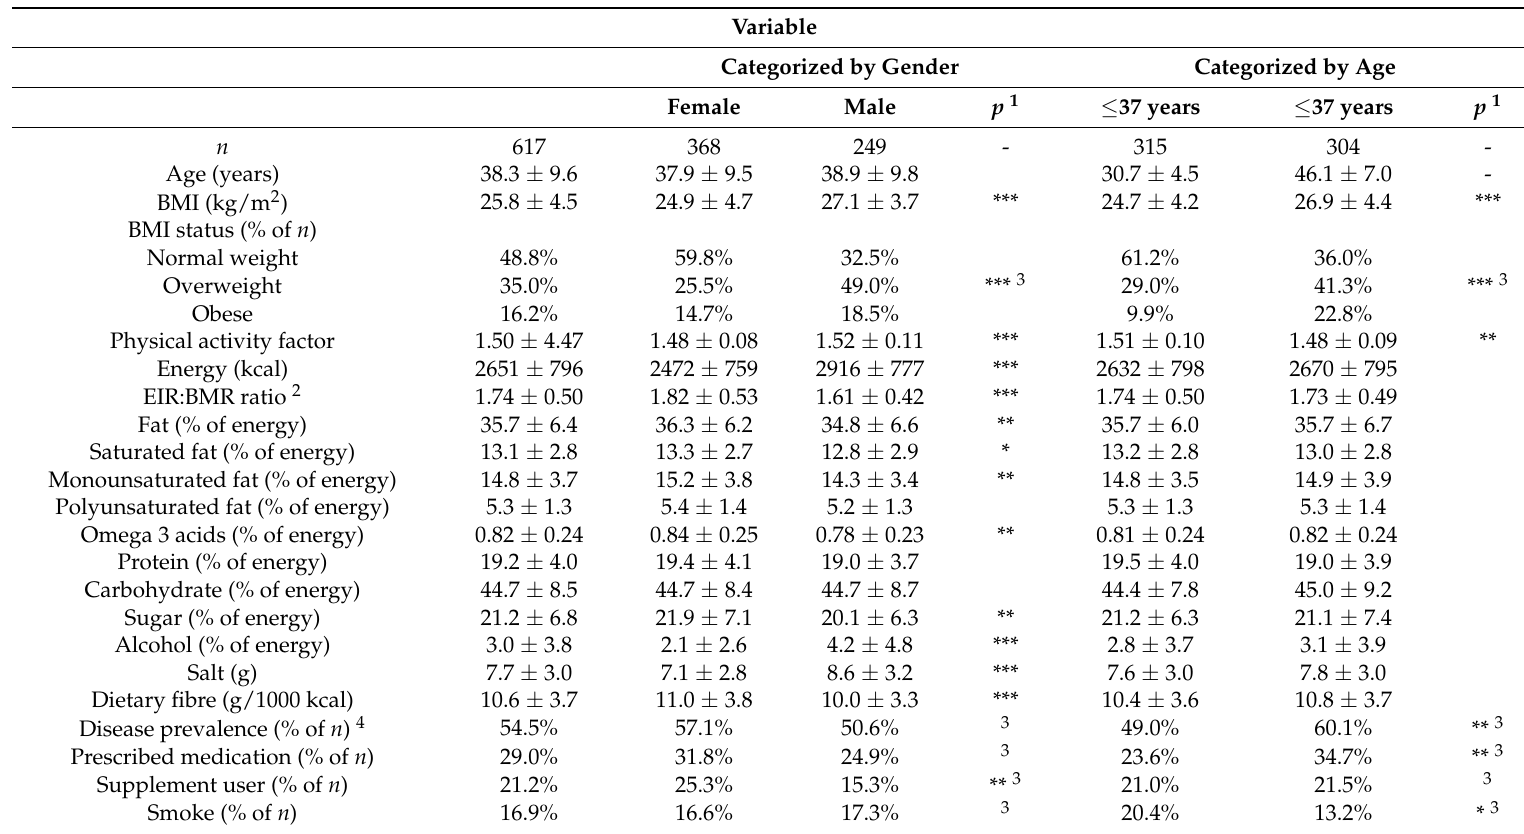
Table 1. Baseline characteristics of Spanish Food4Me volunteers included in the